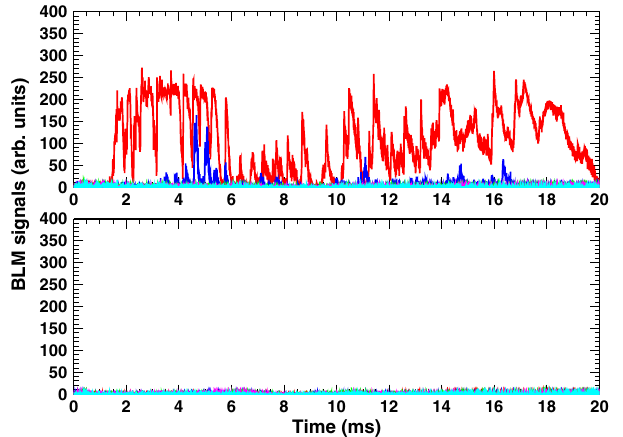
FIG. 25. Scintillation-type BLM signals over the whole time of 20 ms measured at the arc section with various beam intensities of 568 (light blue), 696 (pink), 825 (green), 944 (blue) kW and 1 MW (red) before (upper) and after (lower) the rf power supply upgrade.